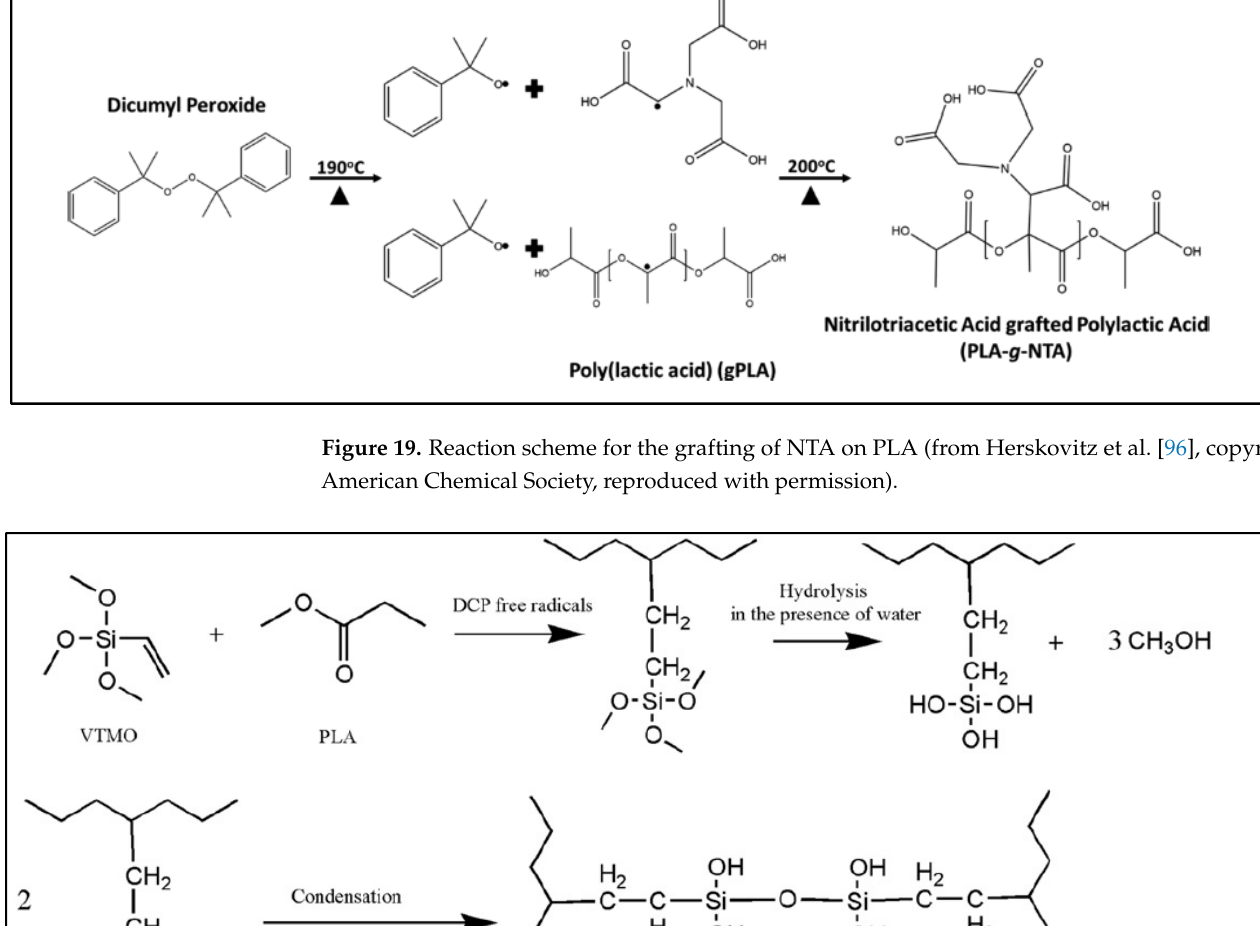
Figure 19. Reaction scheme for the grafting of NTA on PLA (from Herskovitz et al. [96], copyright American Chemical Society, reproduced with permission).